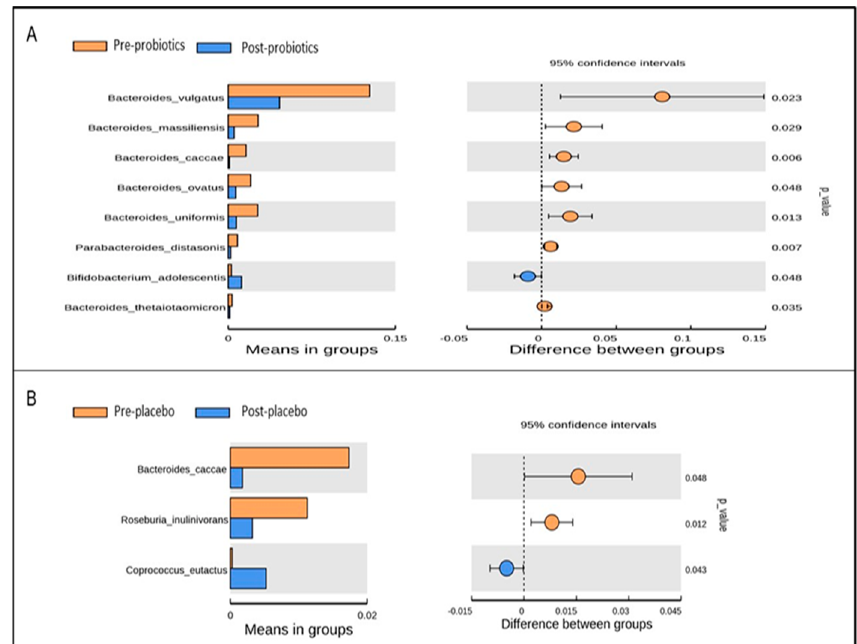
Figure 7. Significantly abundant gut microbial taxa at the species level within the probiotics ( A ) and placebo ( B ) groups pre- and post-intervention, identified using t -test analysis. p -value < 0.05 was considered statistically significant.